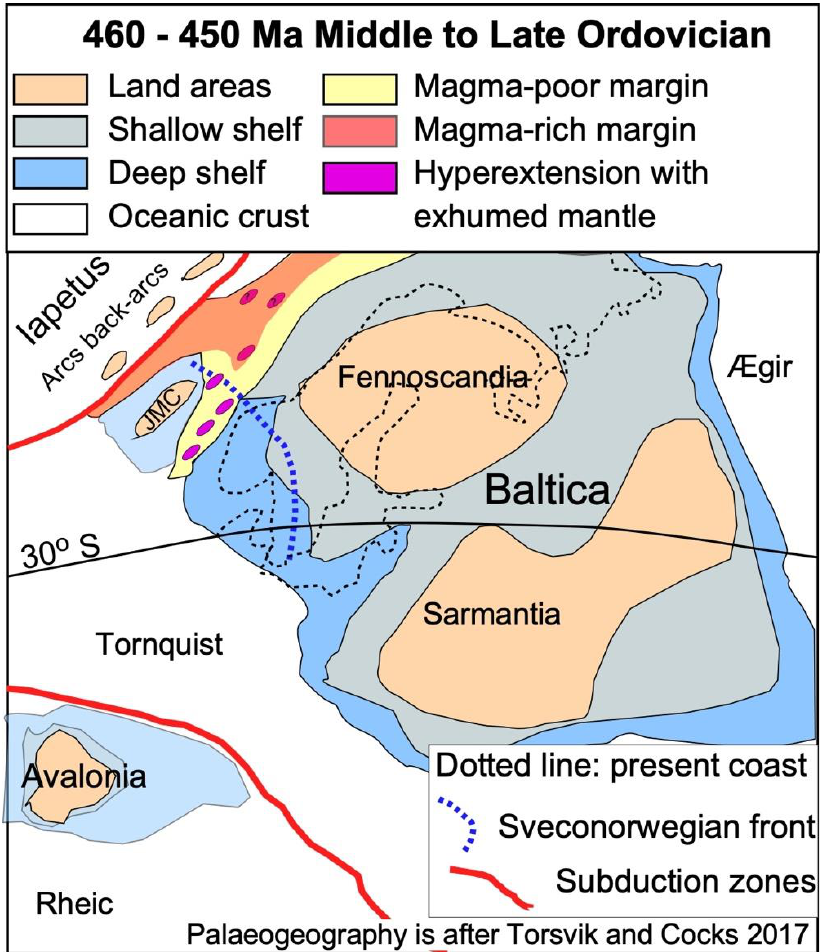
Figure 5. Regional Middle Ordovician plate reconstruction modified from [49], showing Early Caledonian subduction and arc – continent collision zones along the transitional crust basins(s) between the margin of Baltica and the Iapetus. Notice the distribution of the magma-rich and the magma-poor segments in yellow and red, respectively. Deformation along the margin probably started first in the north. Notice also the inboard Jotun Microcontinent (JMC) seaway with transitional crust and abundant mantle exhumation, shown by purple ellipses. The magma-rich margin segments are shown in red. Blue dotted line shows the approximate location of the Sveconorwegian front in the Baltican basement of Fennoscandia. This line coincides with the termination of the Jotun promontory and the transition from the magma-poor inboard JMC segment and the magma-rich outboard segment to the north and west.